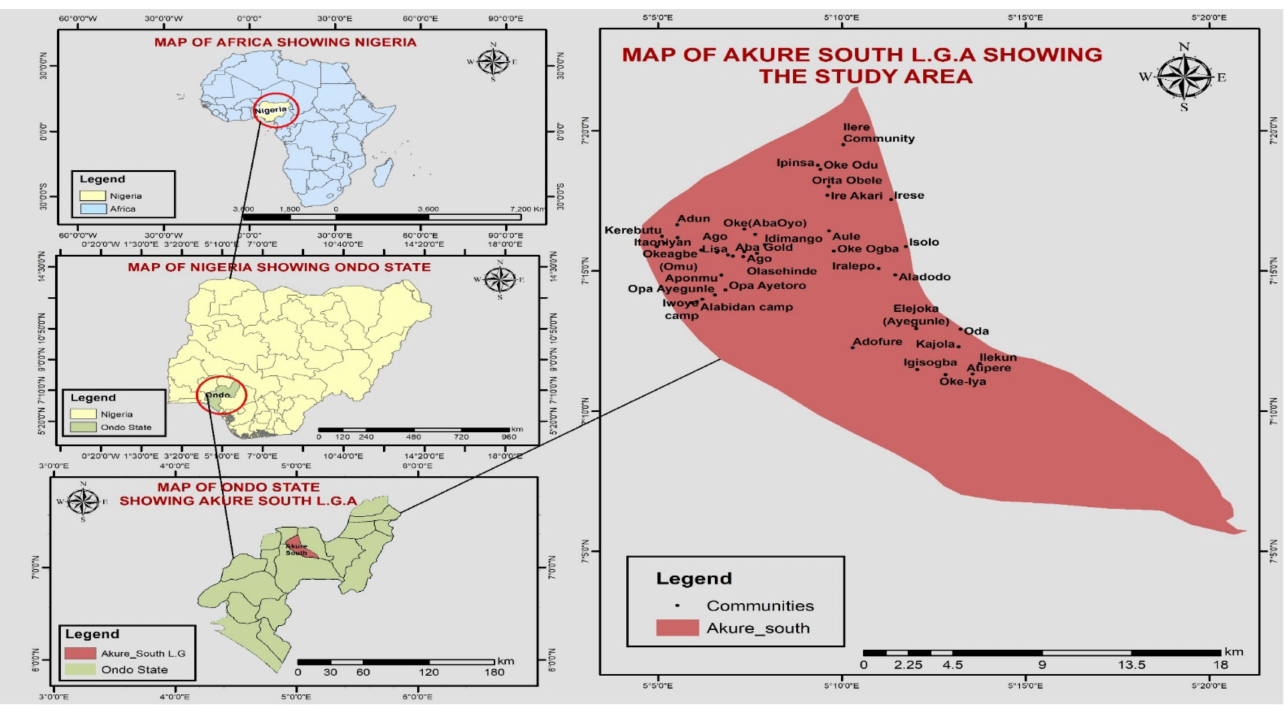
Figure 1. Geographical location of the selected communities in Akure South local government area, Ondo State,